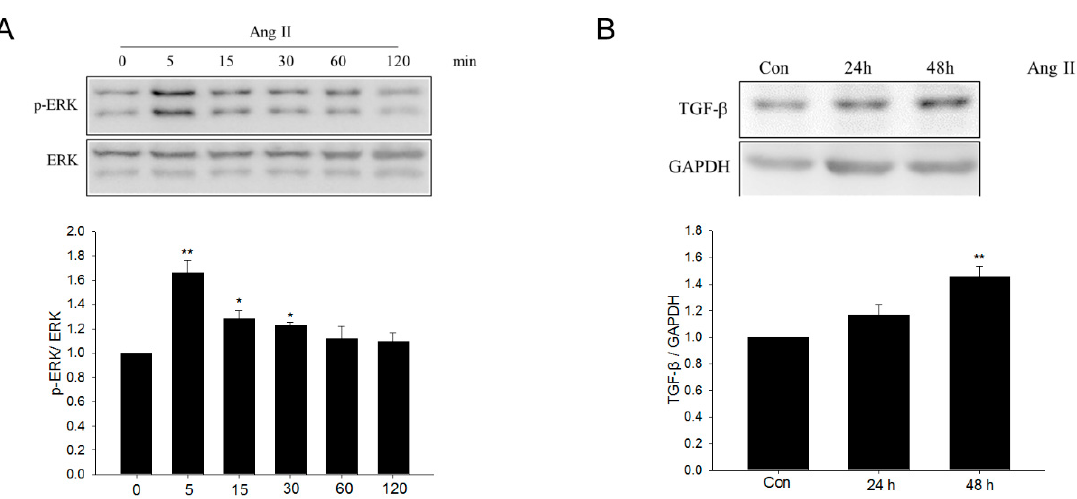
Figure 8. Cont. Figure 8. Cont